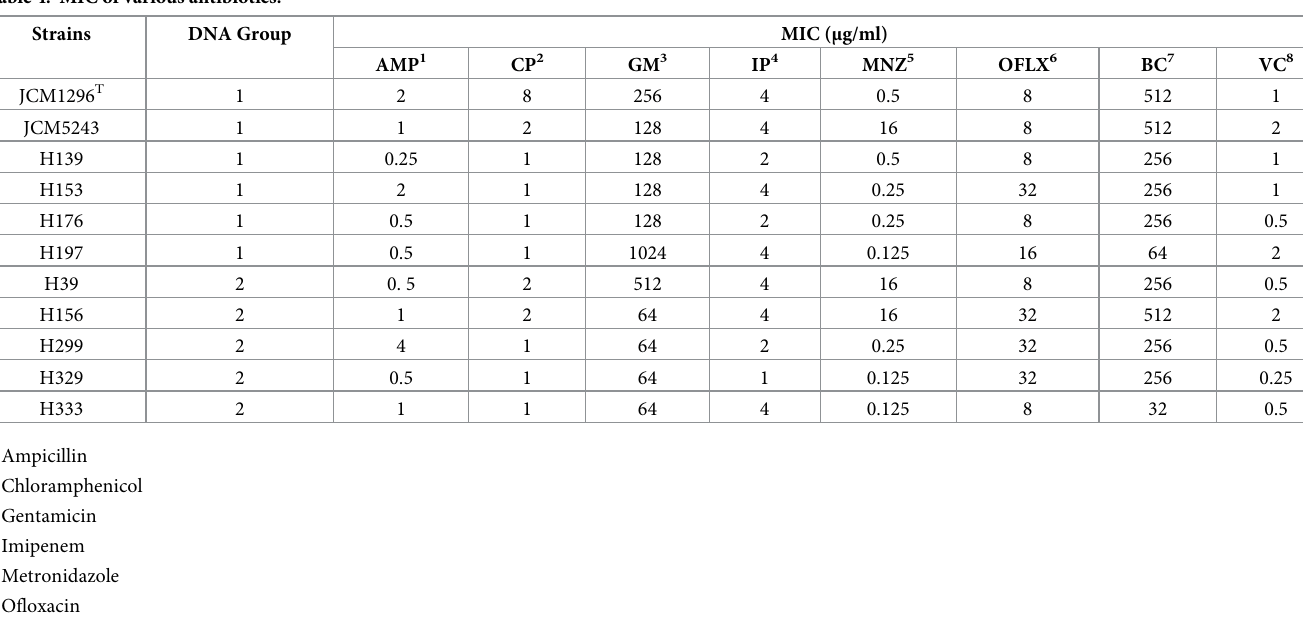
Table 4. MIC of various antibiotics.